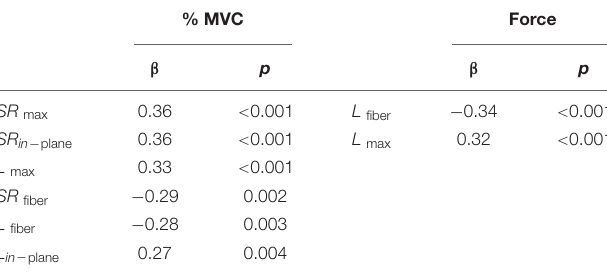
TABLE 3 | Univariate linear regression to %MVC and absolute force for strain and strain rate indices obtained for all the volunteers. %